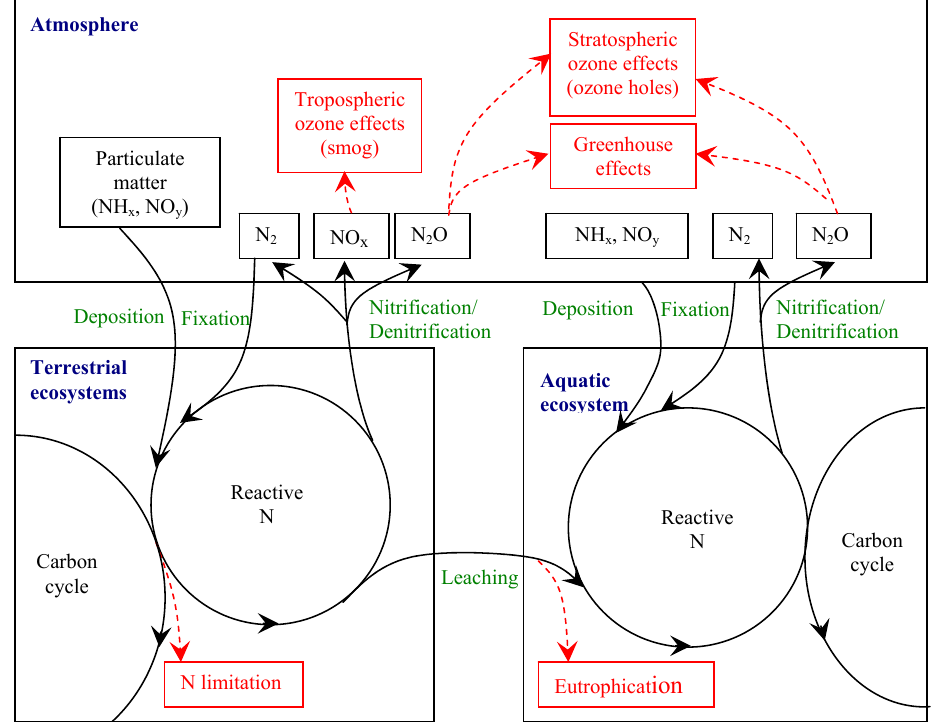
Fig. 1. Diagram of N cycling and its influences on global